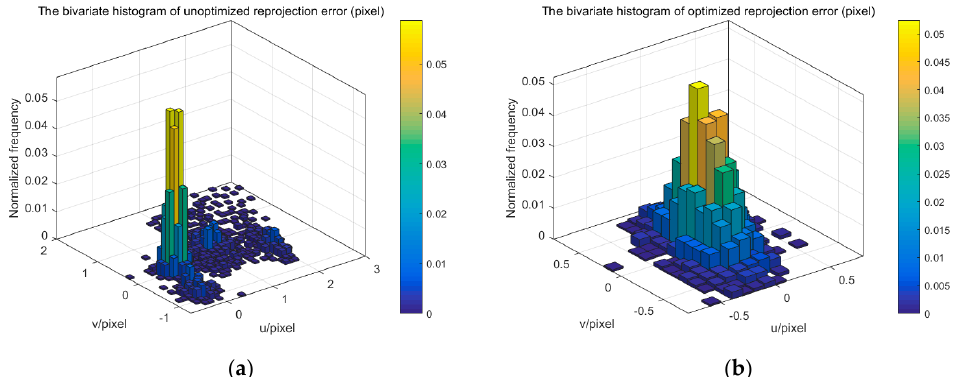
Figure 12. The reprojection error of binocular camera. ( a ) unoptimized; ( b ) optimized.